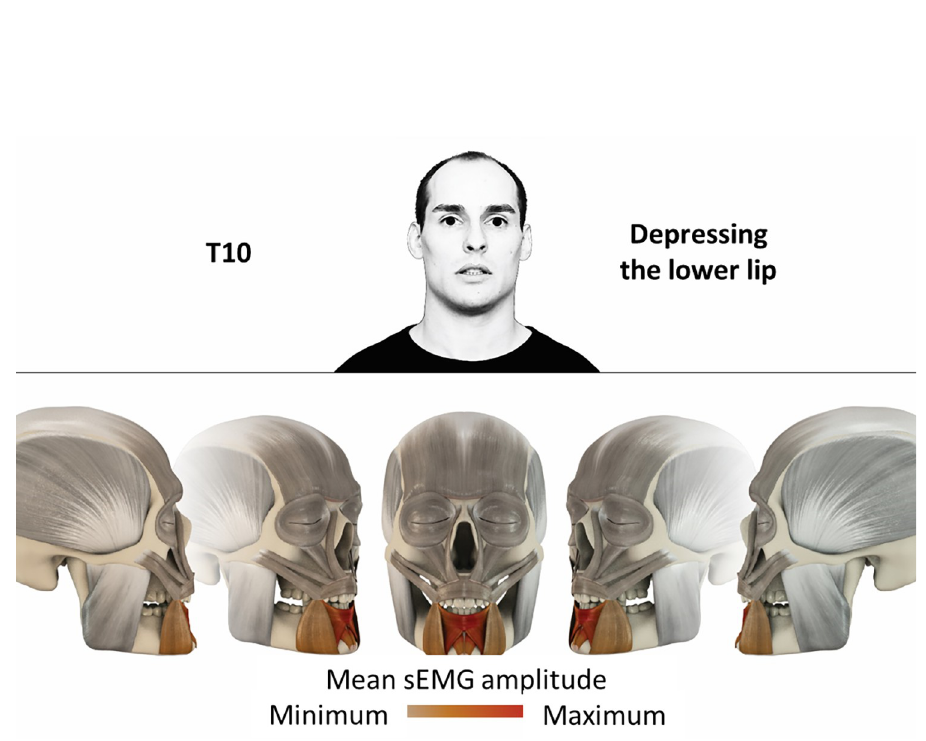
Fig 11. Color-coded facial muscle activation pattern of task T10. Depressing lower lip. Animation by Jonas Laustro¨er.